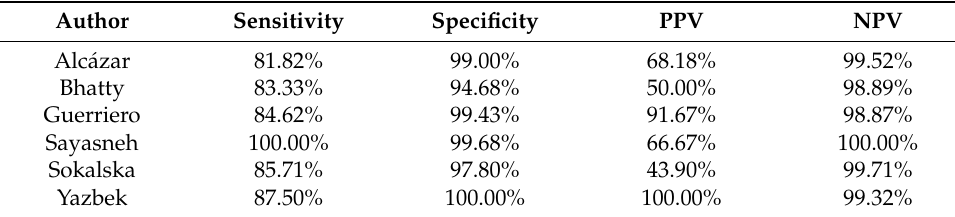
Table 3. Diagnostic performance of each of the studies included in the